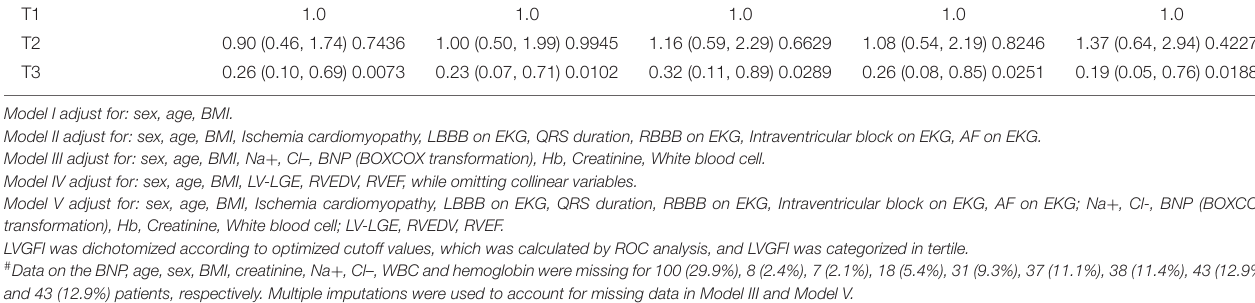
LVGFI, per 1% increase